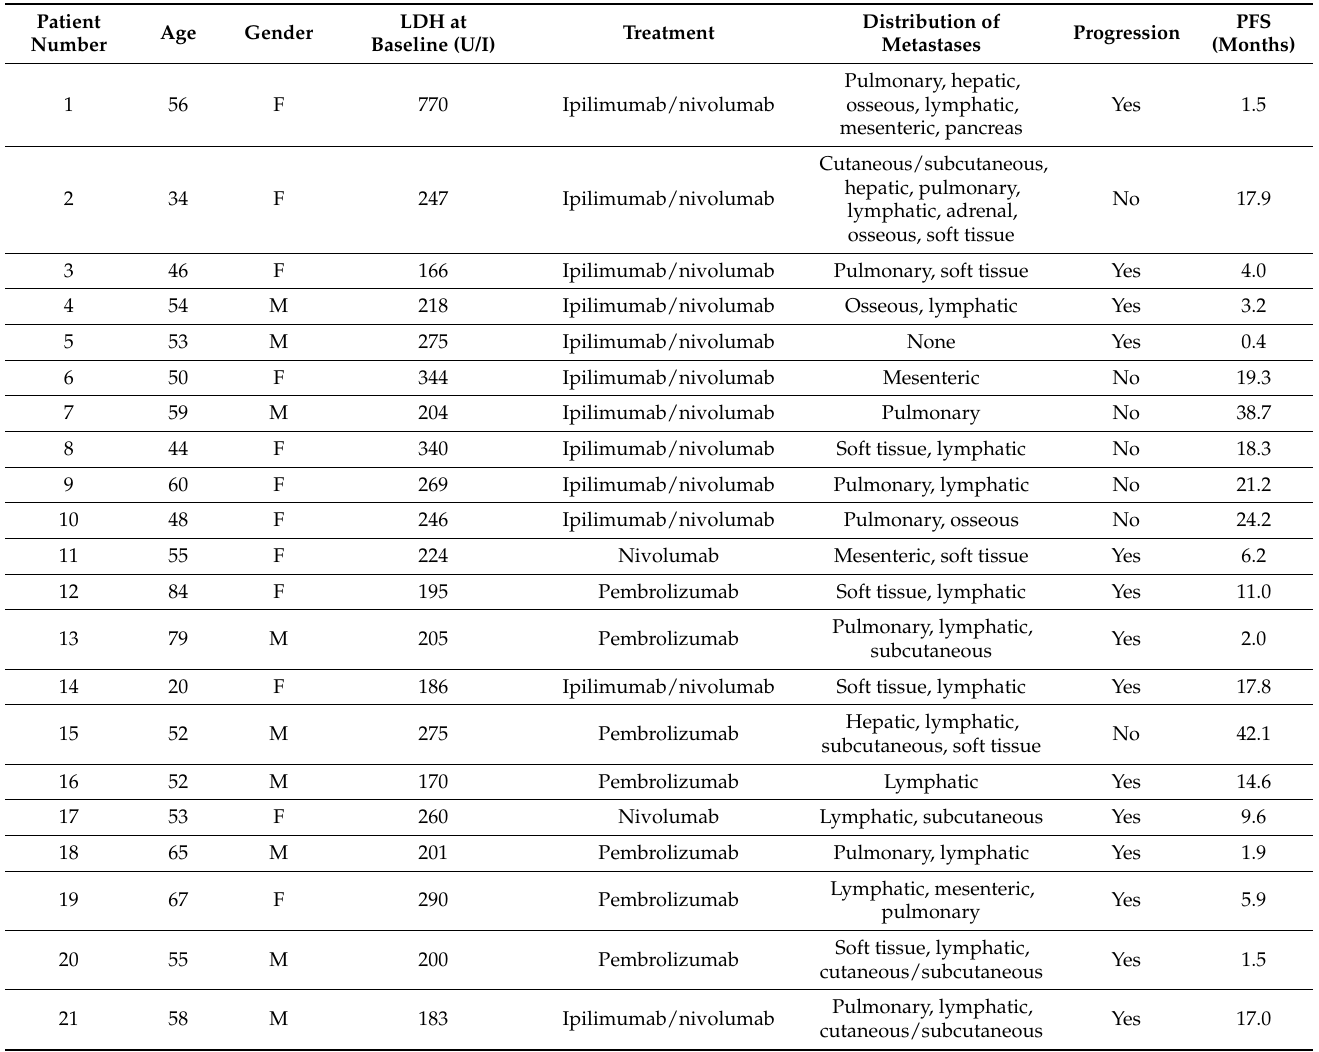
Table 1. Patient